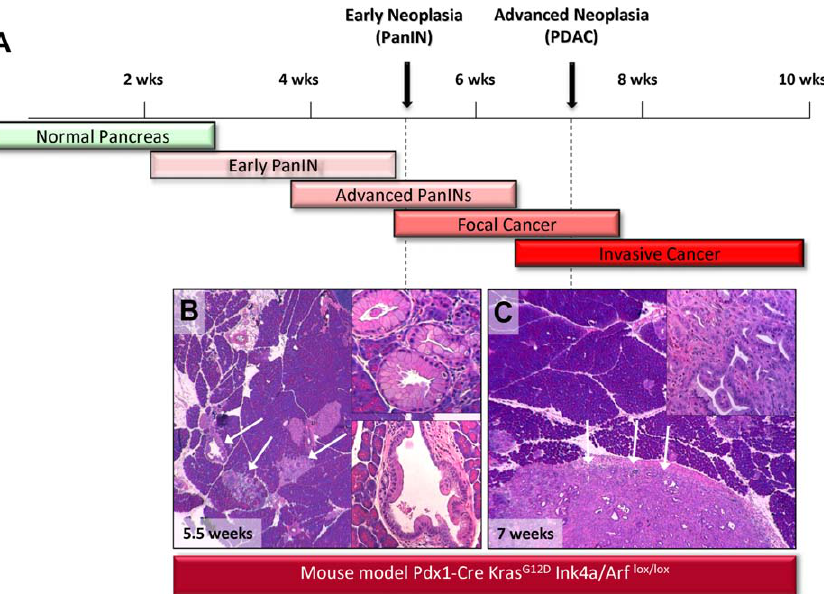
Figure 1. PanIN and PDAC Mice for Plasma Proteomic Analyses (A) Pdx1-Cre Ink4a/Arf lox/lox and Kras G12D Ink4a/Arf lox/lox mice at average of 5.5 and 7 wk of age representing PanIN and PDAC lesions, respectively, were selected on the basis of histological analysis of tumor for this study. (B and C) show representative histology for PanIN and PDAC stages. Plasma was pooled from each disease group and each corresponding age and sex- matched controls to yield 1 ml per phenotype for proteomic analysis. protein solution 7.1 mg D0-acrylamide or 7.4 mg D3-